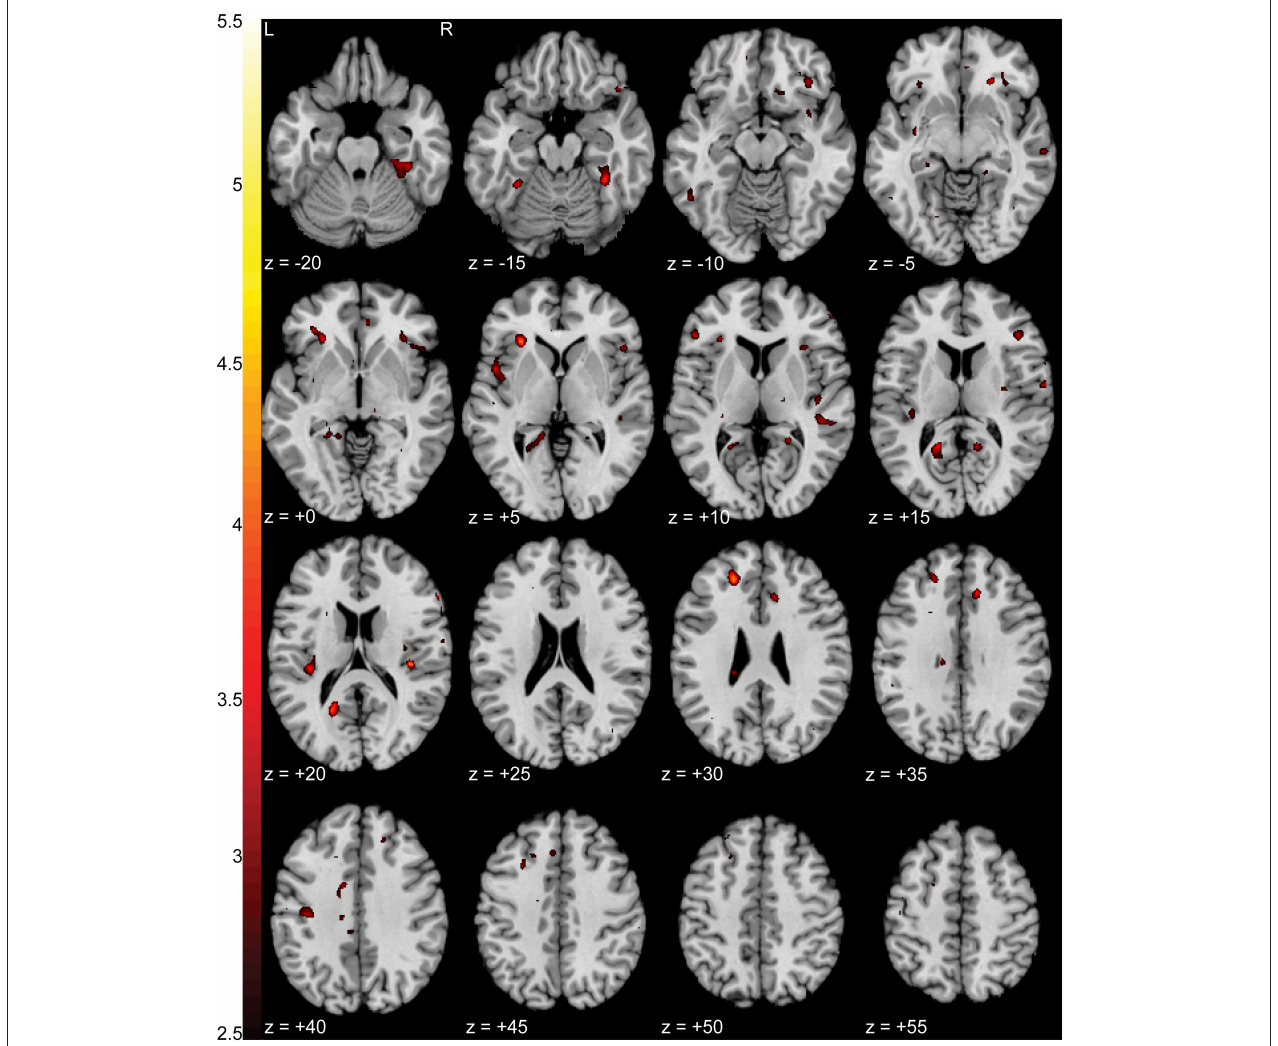
FIGURE 4 | Increased activation in NP subjects compared to controls during the pain focus state in contrast to the non-pain focus state. T-statistic mapping of increased BOLD activation ( p < 0.05 uncorrected) in NP subjects during the pain focus state when compared to the pain minus non-pain contrast in control subjects. Increased activity was seen in bilateral anterior and posterior insula, left retrosplenial cortex, and ventromedial prefrontal cortex. Clusters with fewer than 10 contiguous voxels were filtered for clarity. The difference between axial slices is 5mm and z -values are relative to the AC/PC